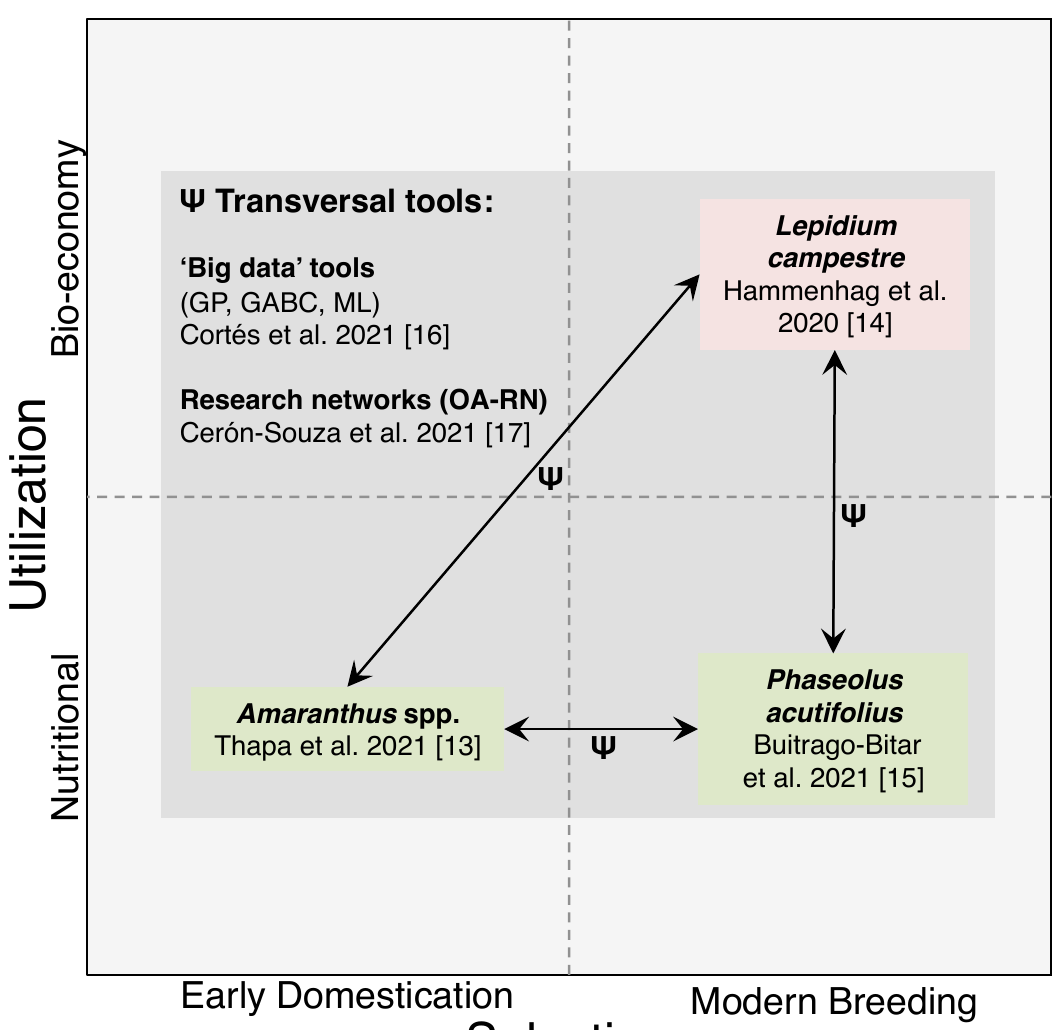
Figure 1. Trans-disciplinary synthesis on crop wild complexes envisioned as part of this Special Issue. Transversal ‘big data’ tools ( Ψ ) [16], and consolidated research networks [17], promise promot- ing research integration around crop wild systems across the multi-dimensional space shaped by fundamental questions (e.g., nature and timing of domestication events, X -axis), and more applied research (e.g., underutilized/understudied crops with potential nutritional and bio-economical value, Y -axis). Specifically, genomic prediction (GP) [18], genomic-assisted back-crossing (GABC), and machine learning (ML) tools [16], boosted by open-access research networks (OA-RN) [17], would allow cohesive learning from early domestication (e.g., amaranth species [13]), and modern breed- ing (e.g., field cress, L. campestre [14]). Additionally, ‘big data’ and OA-RN will enable to unlock more efficiently variation hidden at crop wild complexes with nutritional value (e.g., Phaseolus bean species [15]), and those with a more industrial perspective (e.g., field cress, a promising oil crop for the subarctic [14]). Based on this compilation, we encourage oncoming studies to: (1) explicitly test evolutionary scenarios concerning the domestication of the ancient grain amaranth via approximate Bayesian computation (ABC) demographic inferences [13] and ML [19,20], (2) narrow the genetic mapping of key domestication-related traits in the modern breeding of field cress [14] via genome- wide association studies (GWAS) and GP [18], and (3) utilize tepary bean as a source of adapted alleles for drought tolerance (and potentially heat tolerance) in common bean [15] via inter-specific crossing schemes [21] and more modern GABC-based indirect introgression